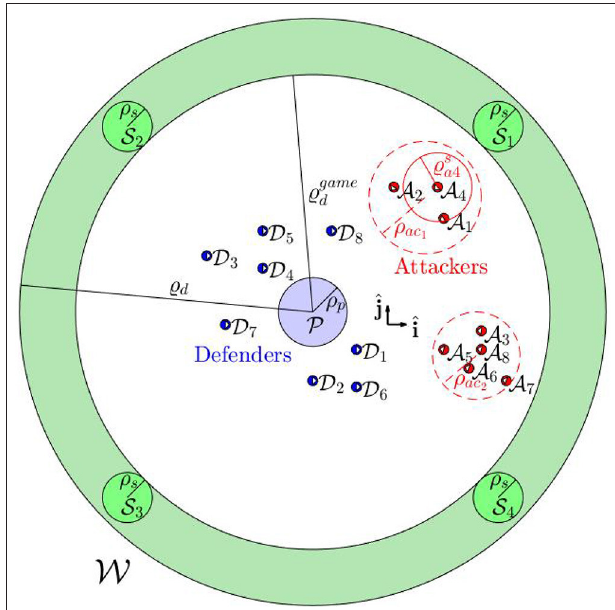
FIGURE 1 | Problem